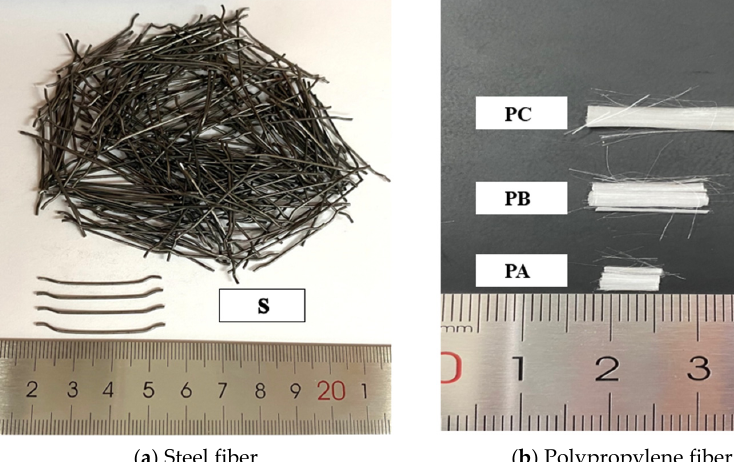
Figure 1. Fiber appearance characteristics.